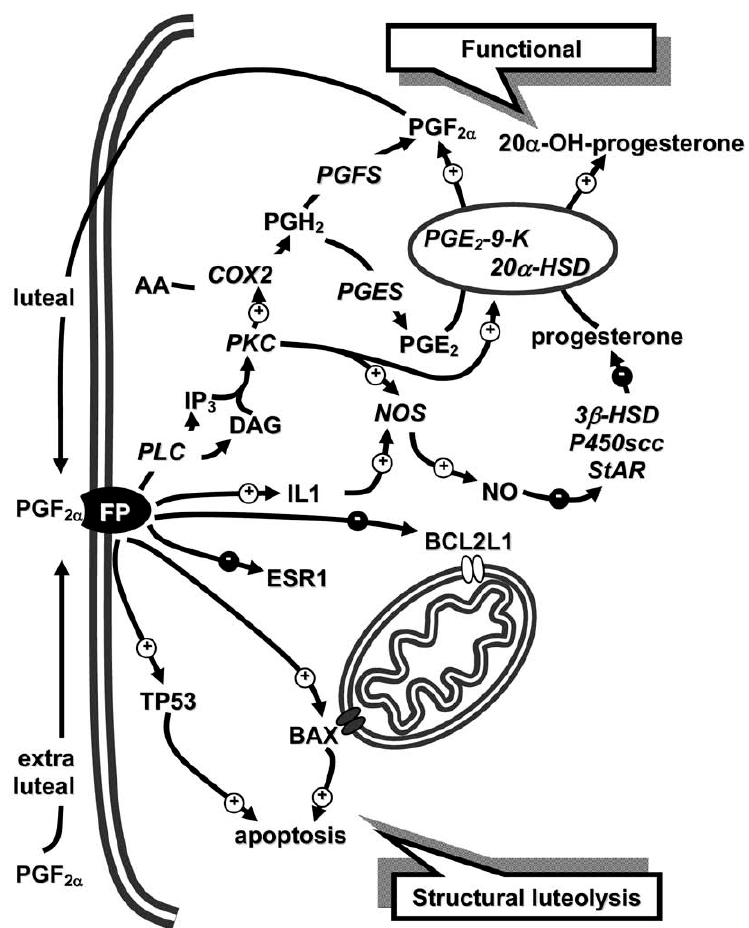
Figure 1. Schematic model reporting the functional (upper) and structural (lower) luteolytic pathways induced by prostaglandin F2 α (PGF2 α ) in rabbit mid-corpora lutea (CL) (day 9 of pseudopregnancy). Since prostaglandin E2 (PGE2)-9-K and 20 α -hydroxysteroid dehydrogenase (HSD) represent two different activities of a single enzyme, they are joined. Figure from the study by Maranesi et al. 2010 [31]. For acronyms, see the list of abbreviations in the